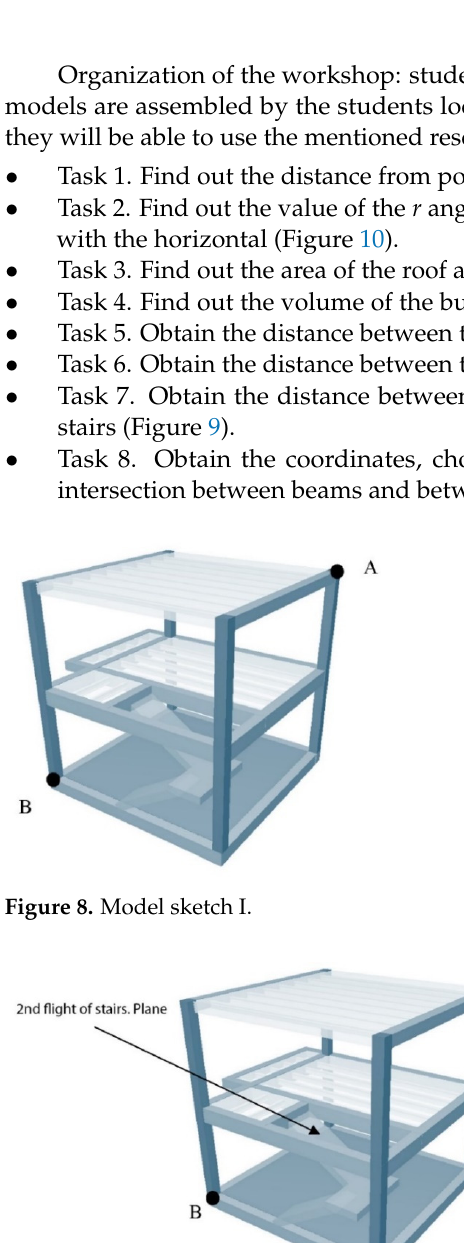
Figure 9. Model sketch II.